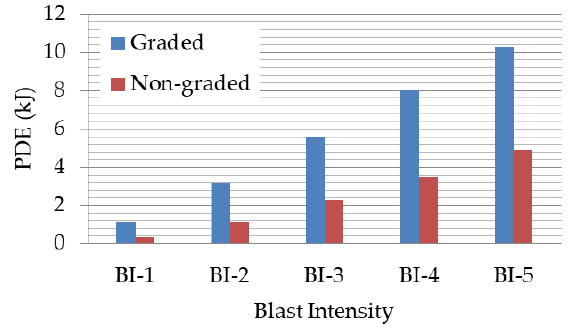
Figure 15. Comparison between the plastic dissipation energy (PDE) of the nongraded and graded trapezoidal cores when subjected to blast intensities BI-1 to BI-5.